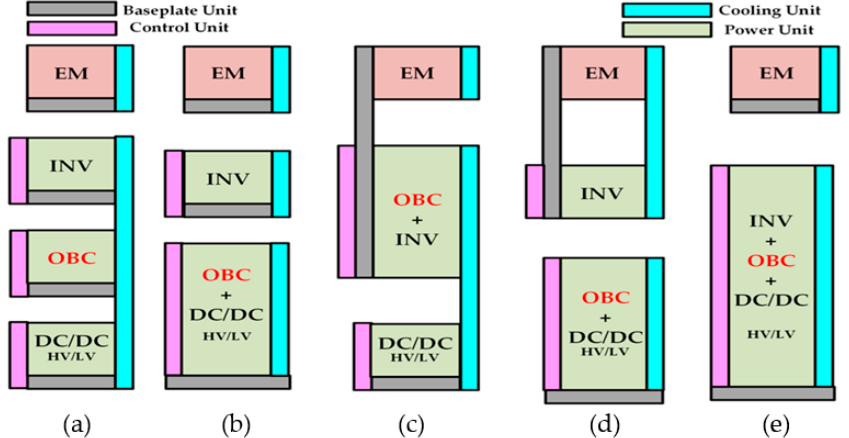
Figure 3. Power/PCB Unit integration approaches. ( a ) Separated power units, ( b ) OBC and DC/DC power unit integration with separate motor drive unit, ( c ) Integrated power unit for OBC and motor drive, ( d ) Power unit integration for OBC and DC/DC unit with separately controlled motor drive, ( e ) Integration of motor drive, OBC and DC/DC control unit.